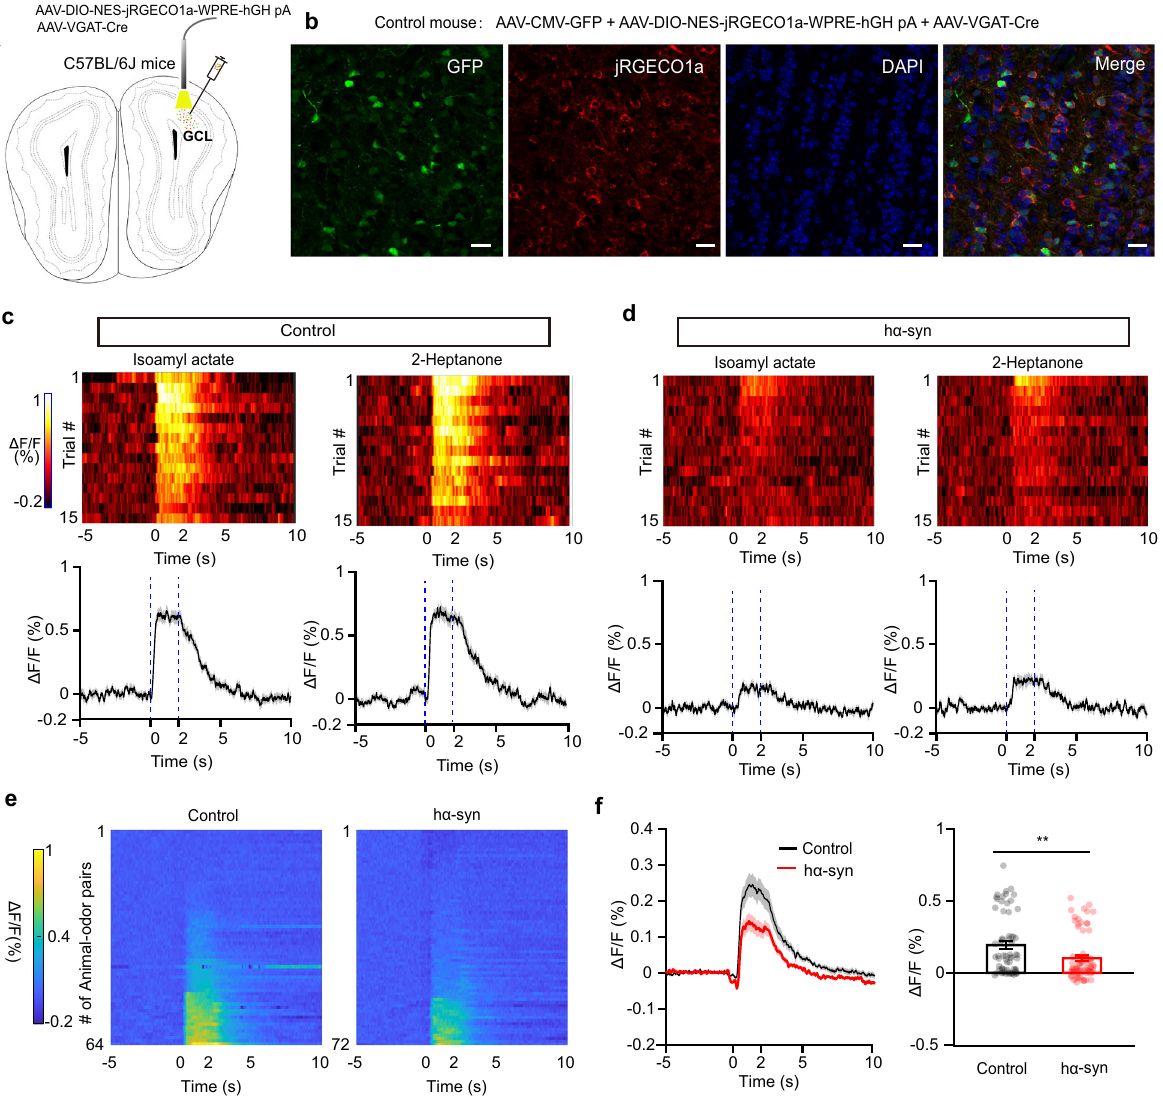
Fig. 7 α -Synuclein aggregates impair the odor-evoked calcium responses of granule cells in vivo. a Schematic for fi ber photometry recording of calcium signals from granule cells expressing jRGECD1a in control or h α -syn mice. b Expression of jRGECD1a in the granule cell layer of the OB from a representative control mouse. Scale bars = 20 μ m. c , d Trial-to-trial pseudo-colored heat maps (top) and trial-averaged traces (bottom; mean ± SEM) of the calcium responses evoked by passive exposure to two different odors, recorded from control ( c ) and h α - syn ( d ) mice. e Heat map illustrating the calcium responses for all animal – odor pairs recorded from control and h α -syn mice. f The averaged calcium response ( Δ F / F , %) of granule cells during odor delivery ( n = 64 and n = 72 animal – odor pairs; control and h α -syn groups, respectively). ** p < 0.01. Data are presented as mean ±